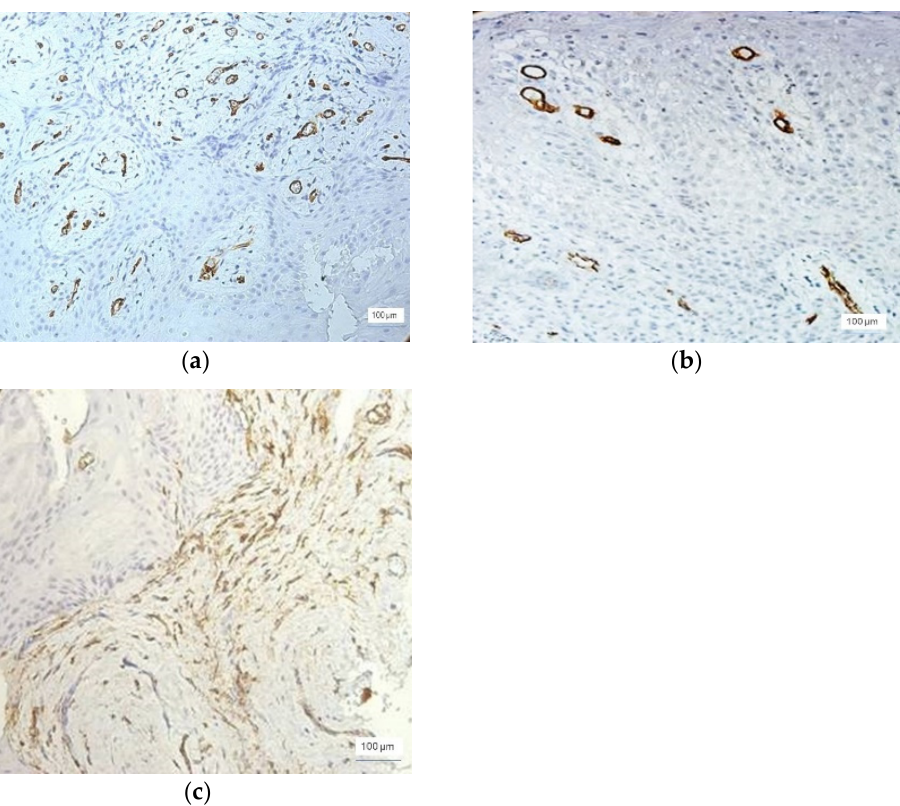
Figure 7. Severe inflammation, GI = 3, increased microvessel density at the stromal level, vascular polymorphism, anti-CD34 immunohistochemical staining, and DAB chromogen, ×100. The presence of small capillary vessels was observed in the gingival epithelium, as well as in the cases with severe inflammation (Figure 8). Capillaries have been identified in the basal layer of the gingival epithelium.